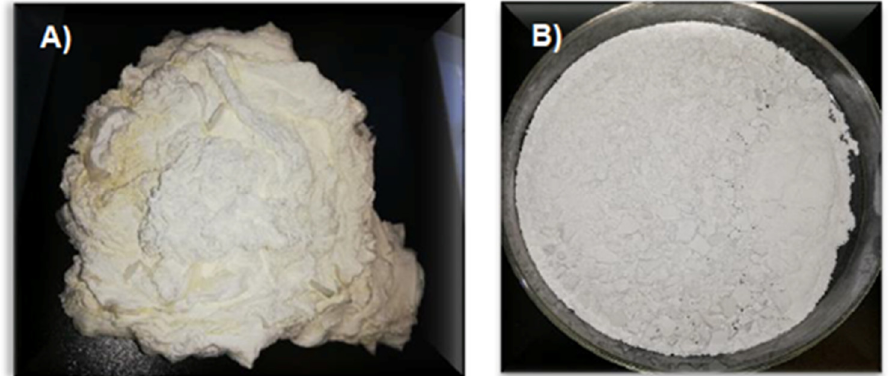
Figure 1. P3HB obtained using different extraction methods: ( A ) hypochlorite–chloroform, ( B ) ethanol–acetone .